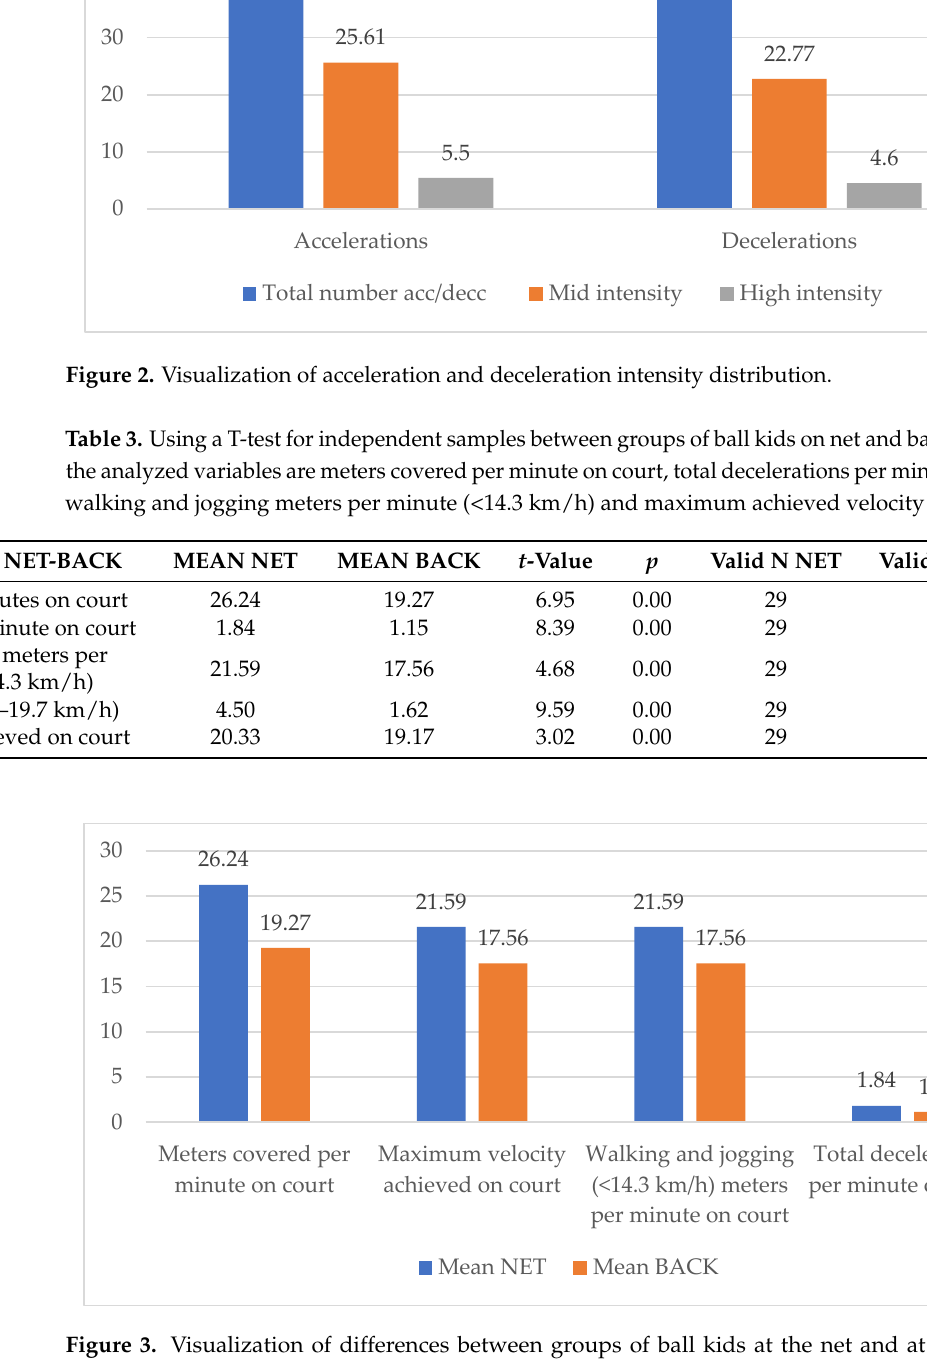
Table 4. Total workload per participant.